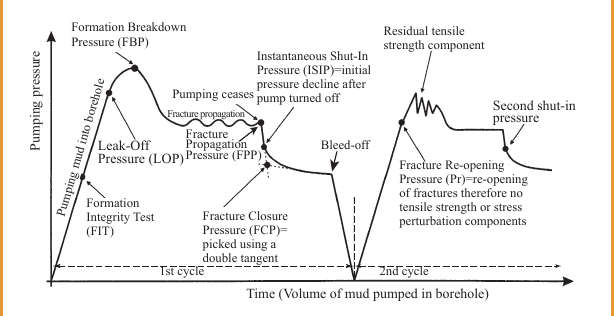
Time (Volume of mud pumped in Figure 2. Idealized relationship between pumping pressure and time or volume of injected fluid during an XLOT (after White et al., 2002).